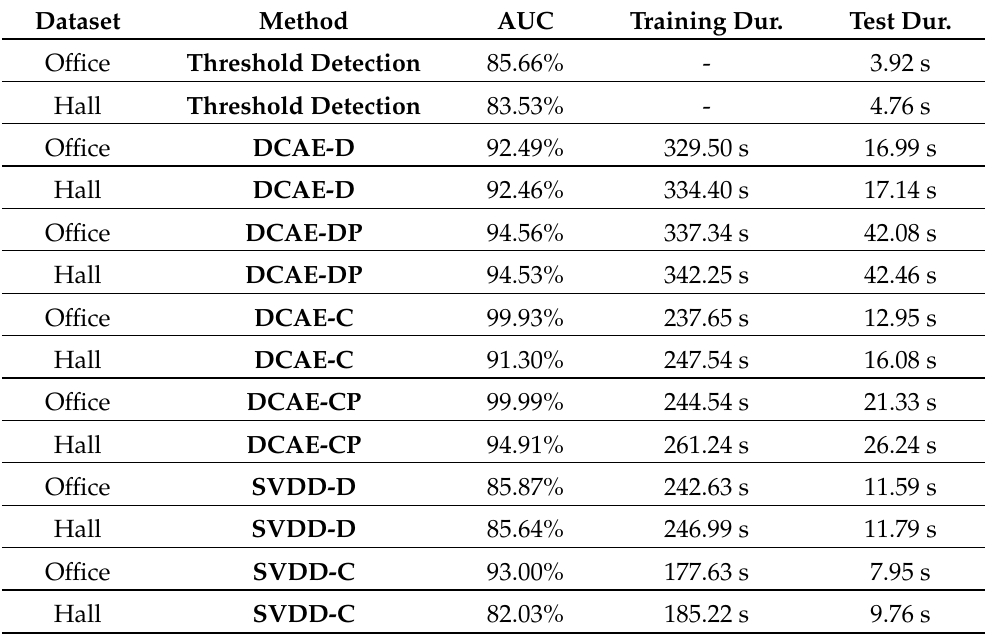
Table 6. Performance of the methods on the measurement data (average over online batches). Dataset